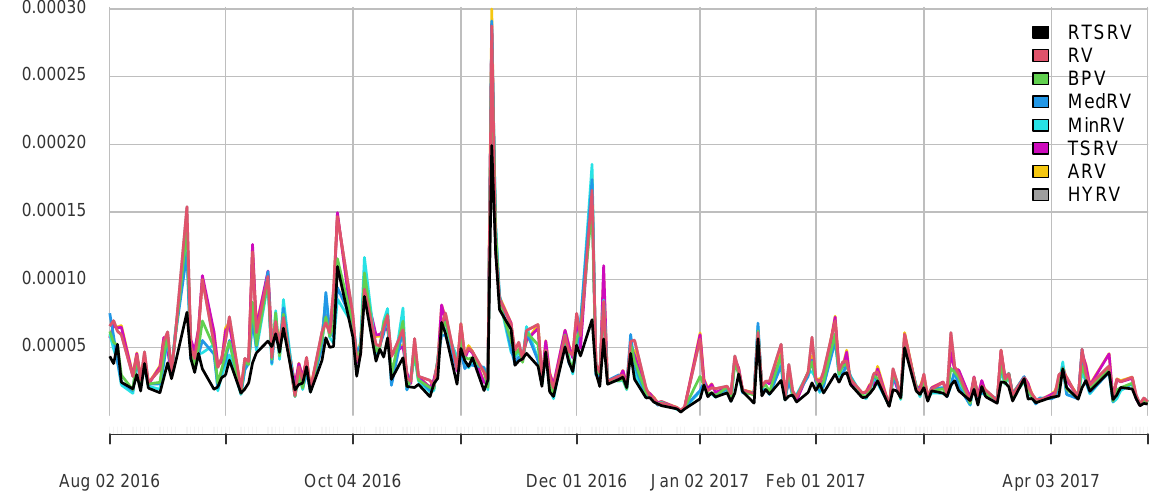
Figure 1. Realized volatility measures within a selected range of data for the DAX